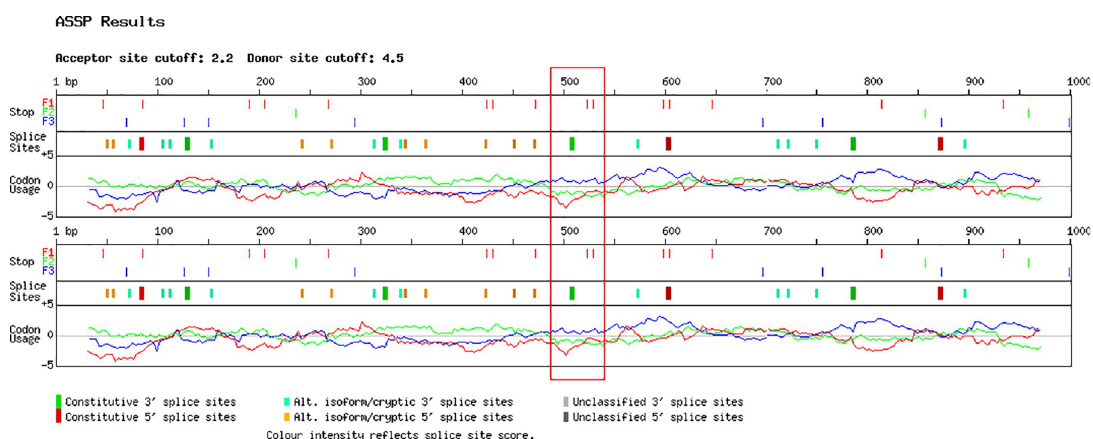
Fig 5. Alternative splicing predictive analysis for GUCY2D c.3044-7G > T. The red box highlights the differences between codon usage of GUCY2D wild-type (at the top) versus GUCY2D carrying the splice variant c.3044-7G > T (at the bottom), suggesting the possible alternative splicing event of mutated gene. More details through the